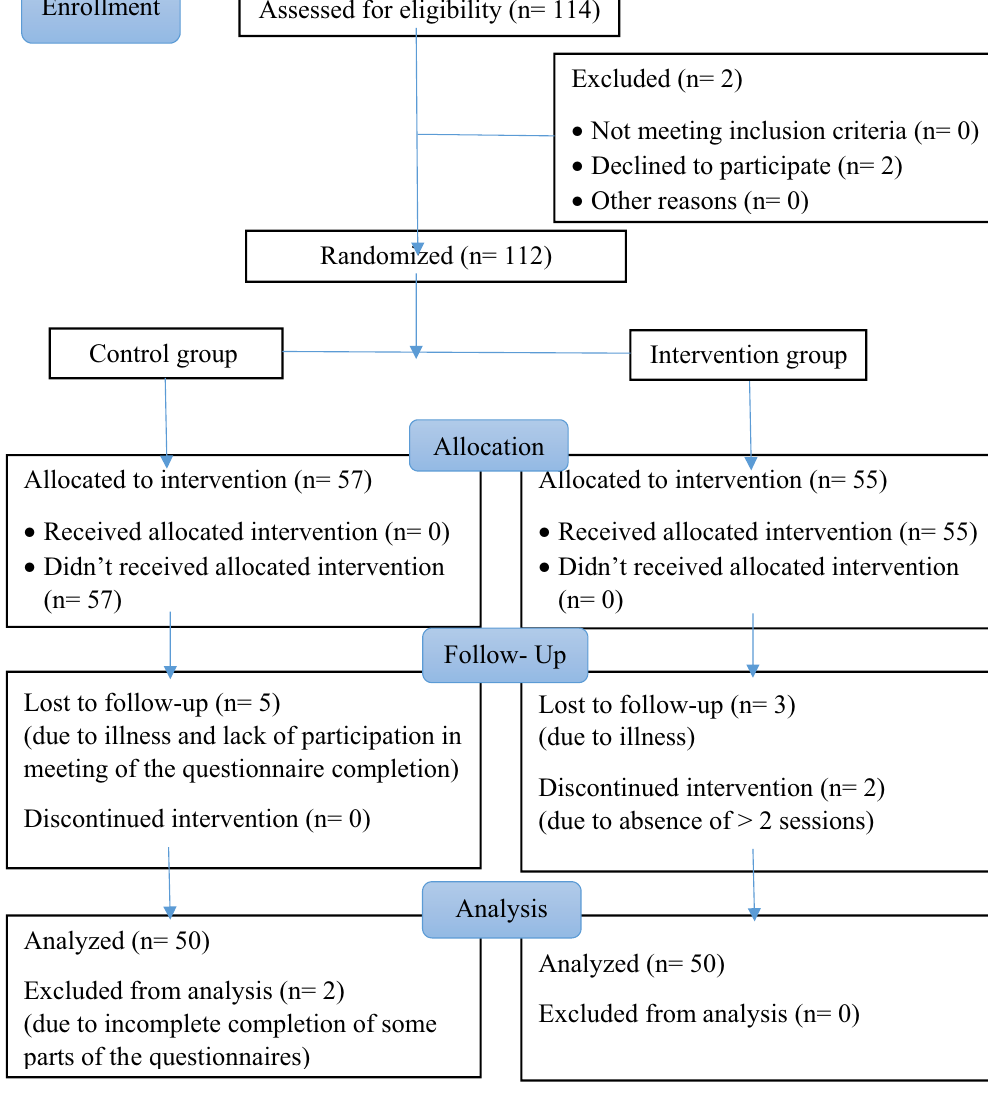
Figure 1. The CONSORT diagram of the study